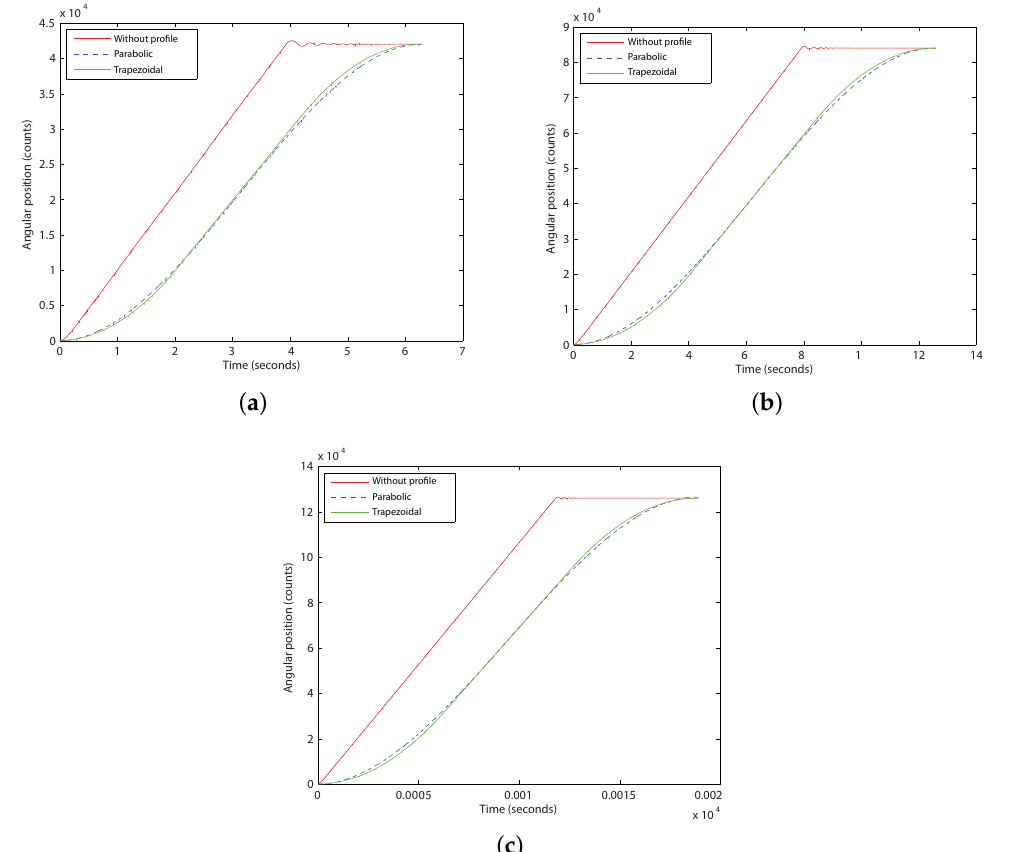
Figure 10. Experimentally obtained response with and without profiles. ( a ) 5 turns. ( b ) 10 turns. ( c ) 15 turns.